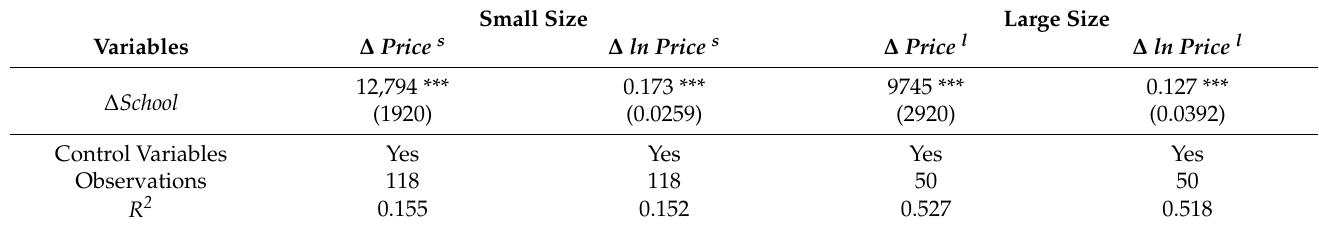
Table 6. Heterogeneous effects for small and large houses (paired difference